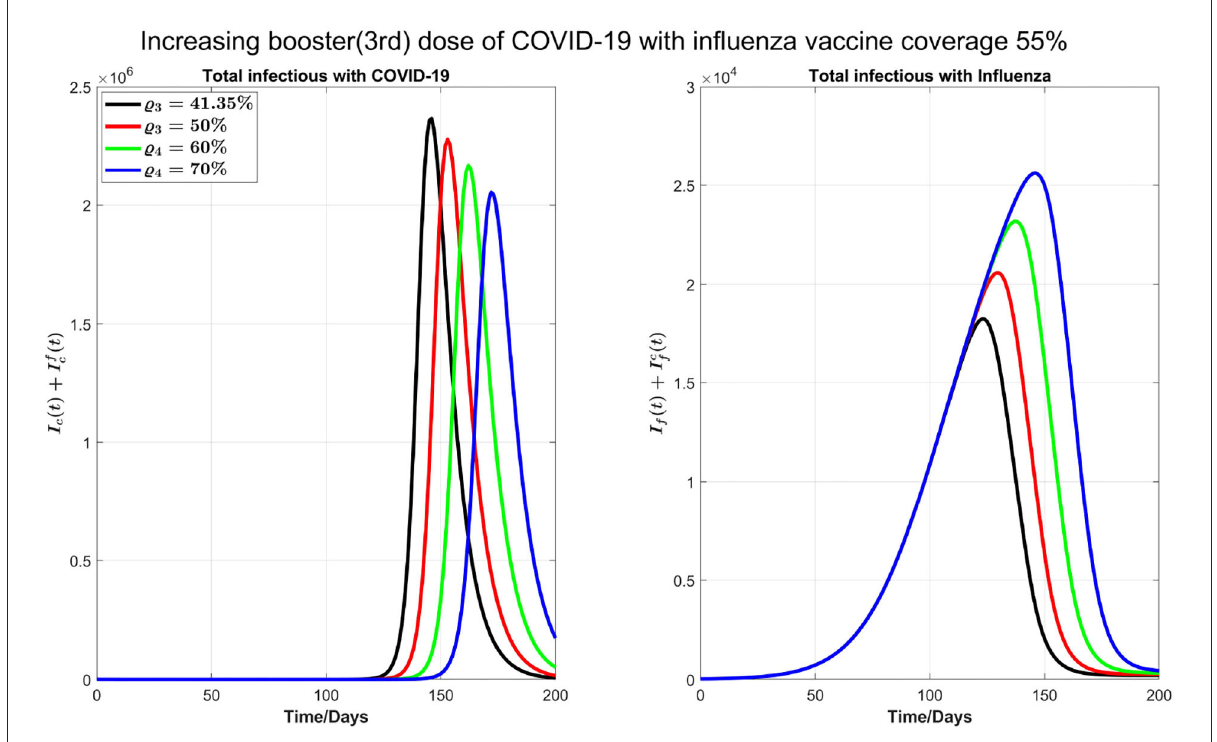
FIGURE6 Increasing booster dose when influenza vaccine coverage also increases to